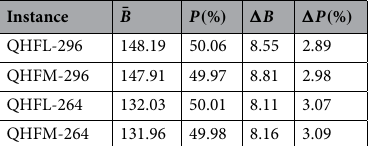
Table 3. Results of diffusion and confusion tests.